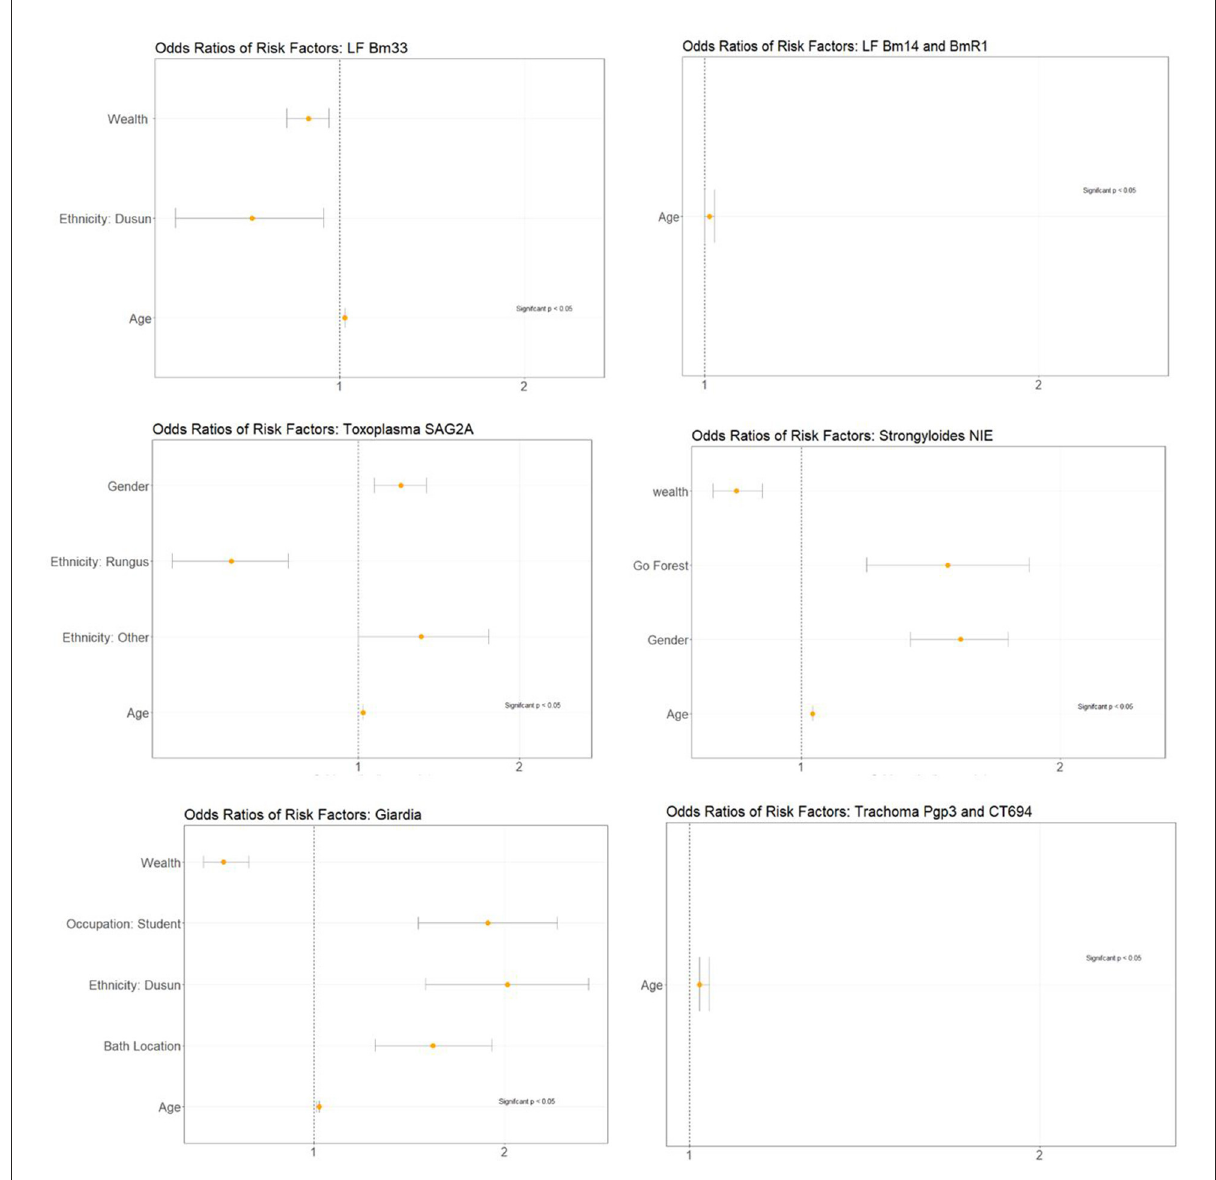
FIGURE2 Adjusted odd ratio plots for associated disease risk